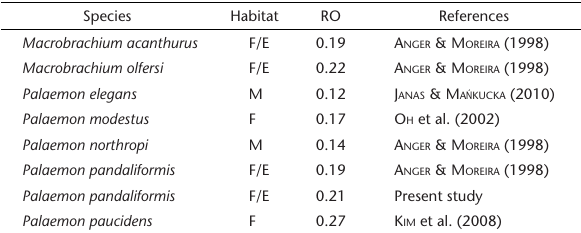
Table 4. Comparison of reproductive output (RO) between studies of Palaemonid shrimps from different habitats. (E) Estuarine, (F) freshwater, (M) marine.